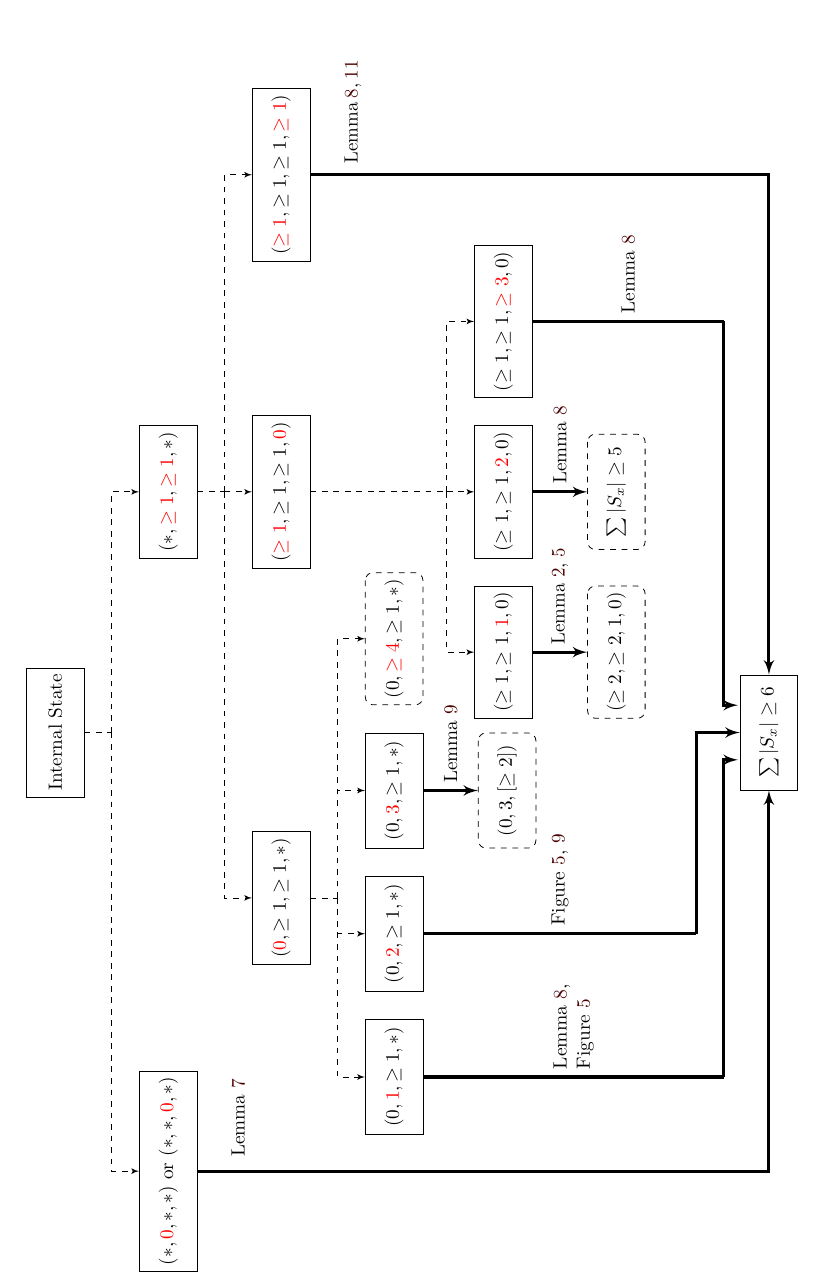
Figure 8: General structure of the proof in Section 5.2 for the internal state part. A thick arrow represents a proven implication, hashed arrows represent subcases that are split and a square parenthesis represents the sum of two states. A hashed box denotes the fact that it is subdivided into two subcases— P | S x | = 5 and P | S x | ≥